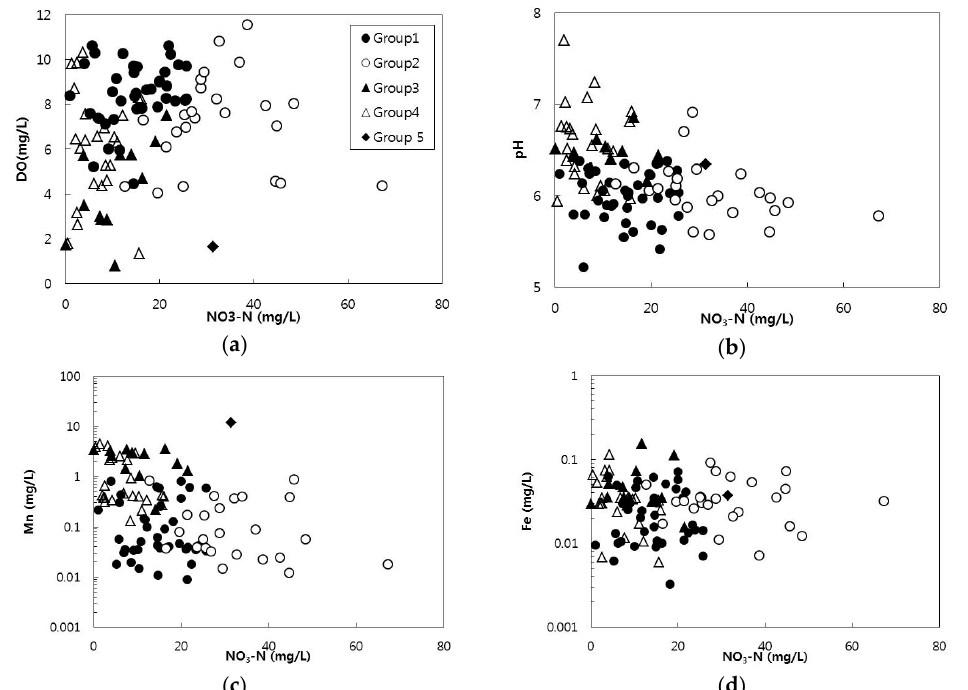
Figure 8. Bivariate relations of the samples in clustered groups between NO 3 –N and some hydrochemical parameters: ( a ) NO 3 –N vs. pH; ( b ) NO 3 –N vs. pH; ( c ) NO 3 –N vs. Mn; ( d ) NO 3 –N vs. Fe.